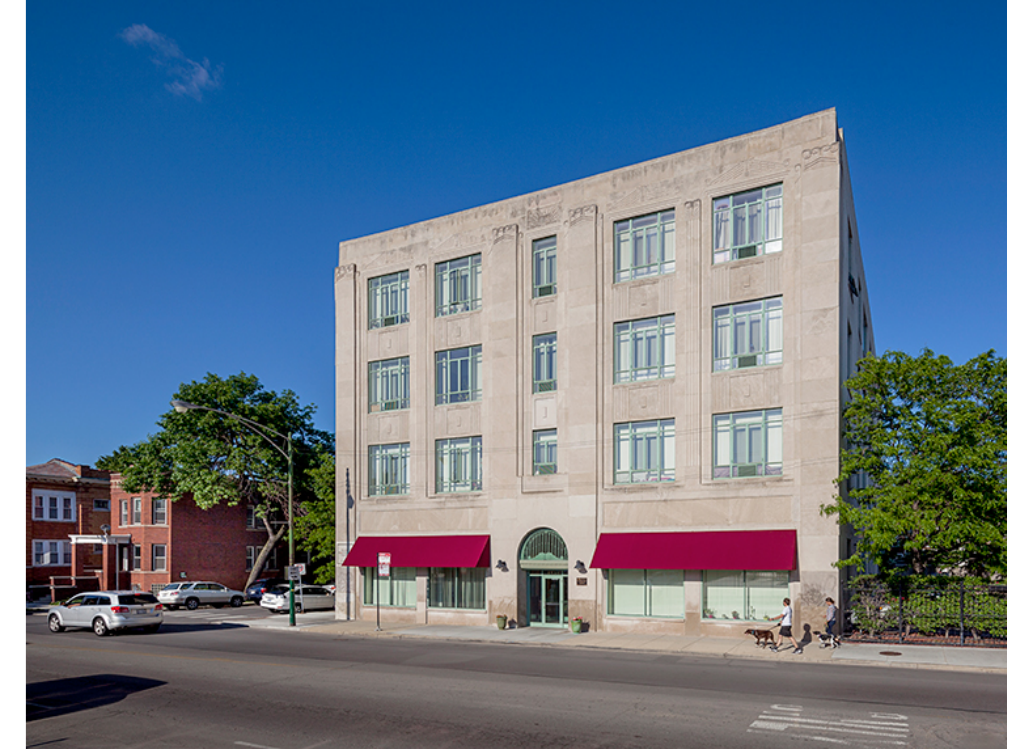
Figure 1: Reverend Alvarez Senior Apartments Puerto Rican migration and urban life in